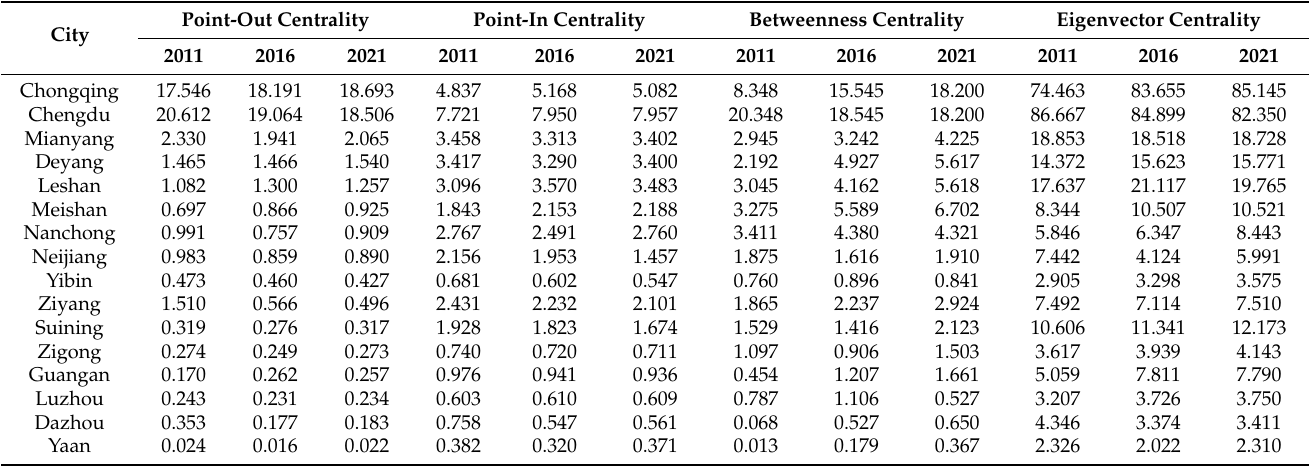
Table 5. Centrality of economic networks in